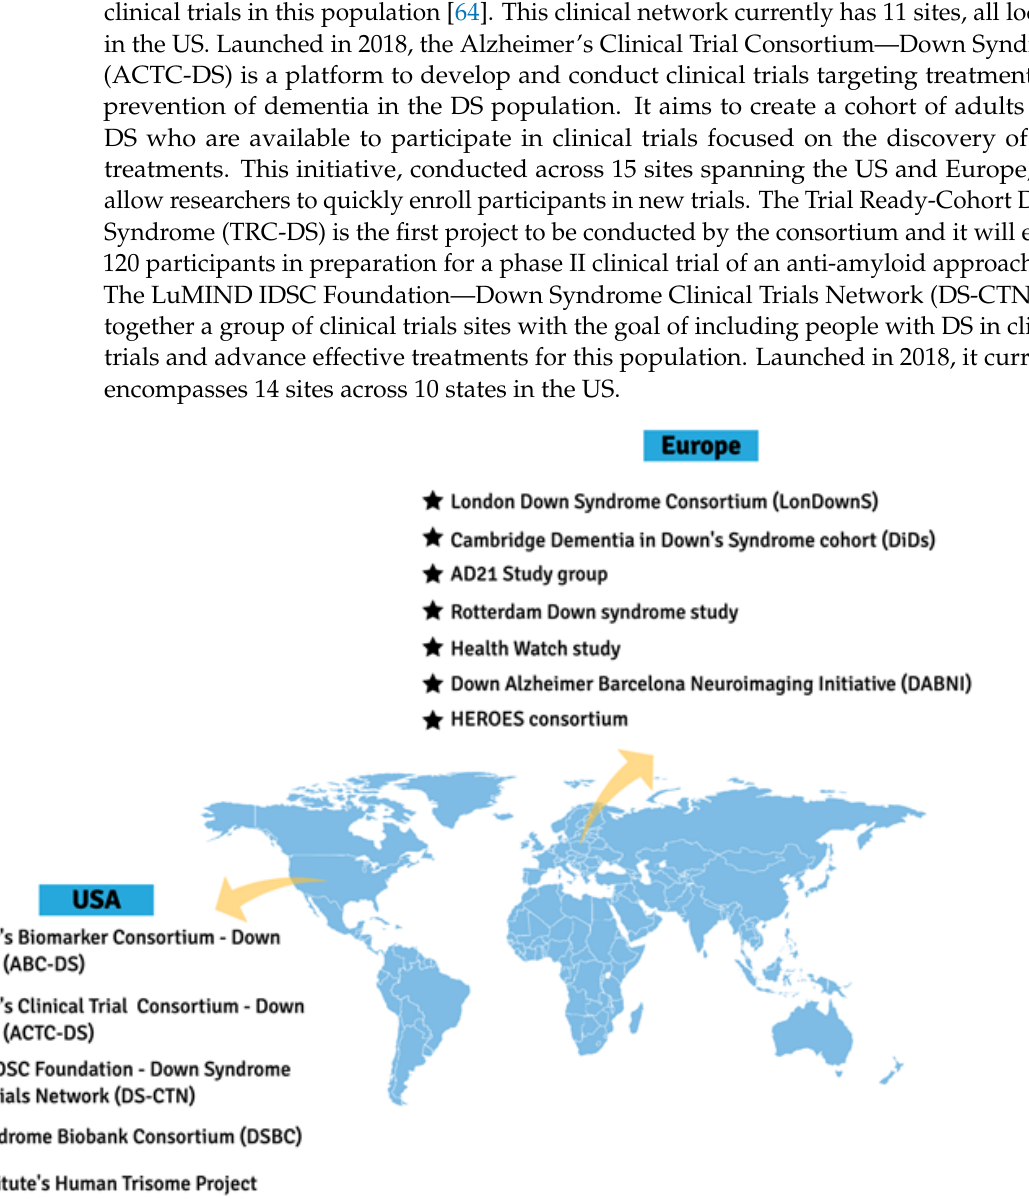
Figure 2. Clinical networks focused on DS in the US and Europe. There are several well-characterized cohorts of adults with DS in Europe, now representing the Horizon 21 consortium, which currently includes 10 different countries in Europe. In the US, there are also several networks, including the AD Biomarker consortium (ABC-DS), the Down syndrome Biobank consortium for collection of brain tissues (DSBC), the LIFE-DSR trial-ready population, and the Crnic Institute’s Human Trisome Project, focused on genetic alterations.